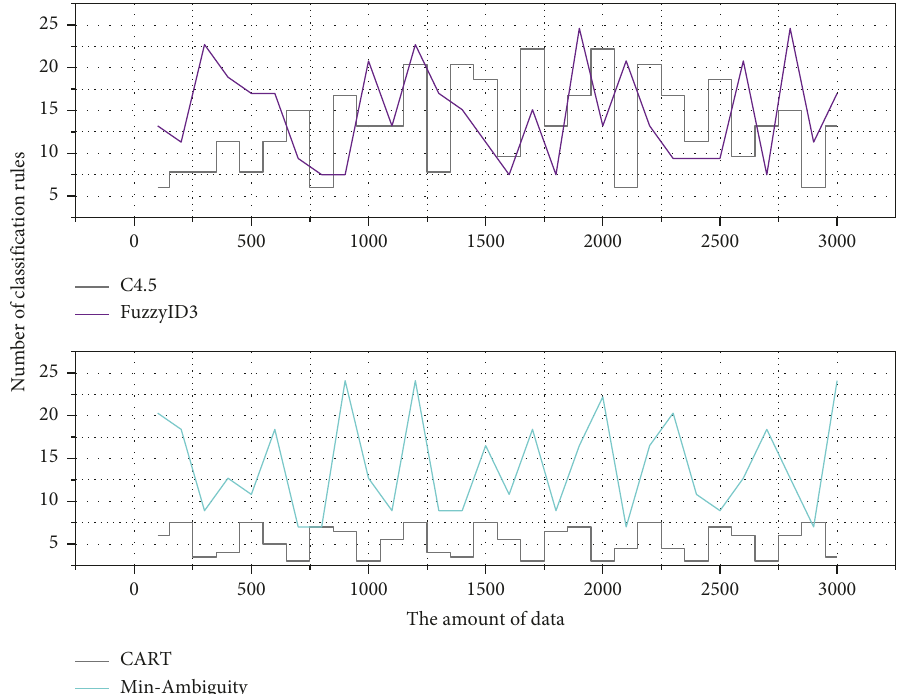
Figure 4: Statistics of the number of classification rules generated by four